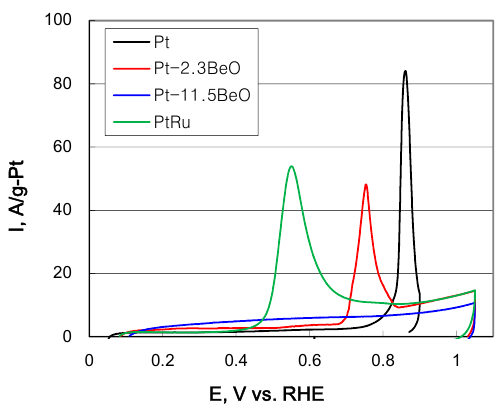
Figure 5. CO stripping voltammetry of carbon-supported Pt, Pt–BeO, and PtRu.